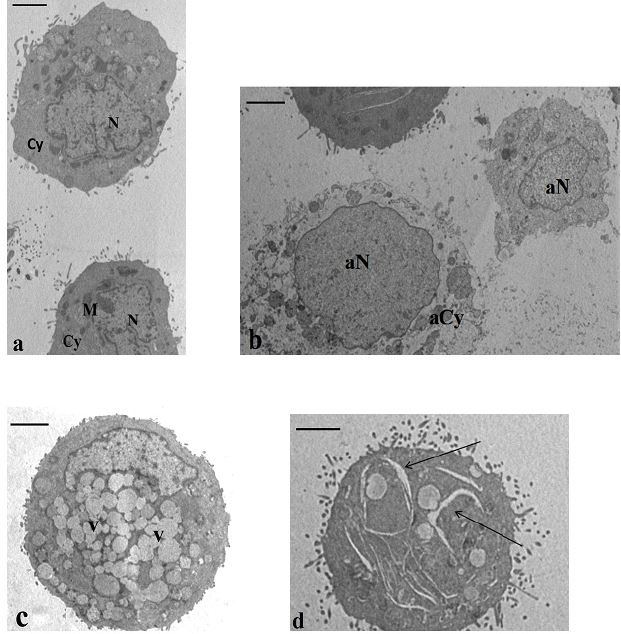
Figure 5. Transmission electron microscopy (TEM) sections of cultured HT-29 cells. ( a ) Baseline conditions. The cells showed normal nuclei (N), regular chromatin texture, and cytoplasm (Cy) containing the typical organelles’ mitochondria (M). Bar 3.5 µ m. ( b – d ) Incubation with CB83, THC, and CBD. In all samples, a high percentage of cells with necrotic and apoptotic features was described. In ( b ), a necrotic cell is evidenced in an altered chromatin texture (aN) and a cytoplasm devoid of organelles (aCy) and, in ( c ), is represented in an apoptotic cell with a cytoplasm rich in vacuoles (V). The cell showed in ( d ) highlights enlargements in the cytoplasm (arrows). This feature was detected in a percentage of 8–12% in all treated samples. ( b , d ) Bar 3.5 µ m. ( c ) Bar 3 µ